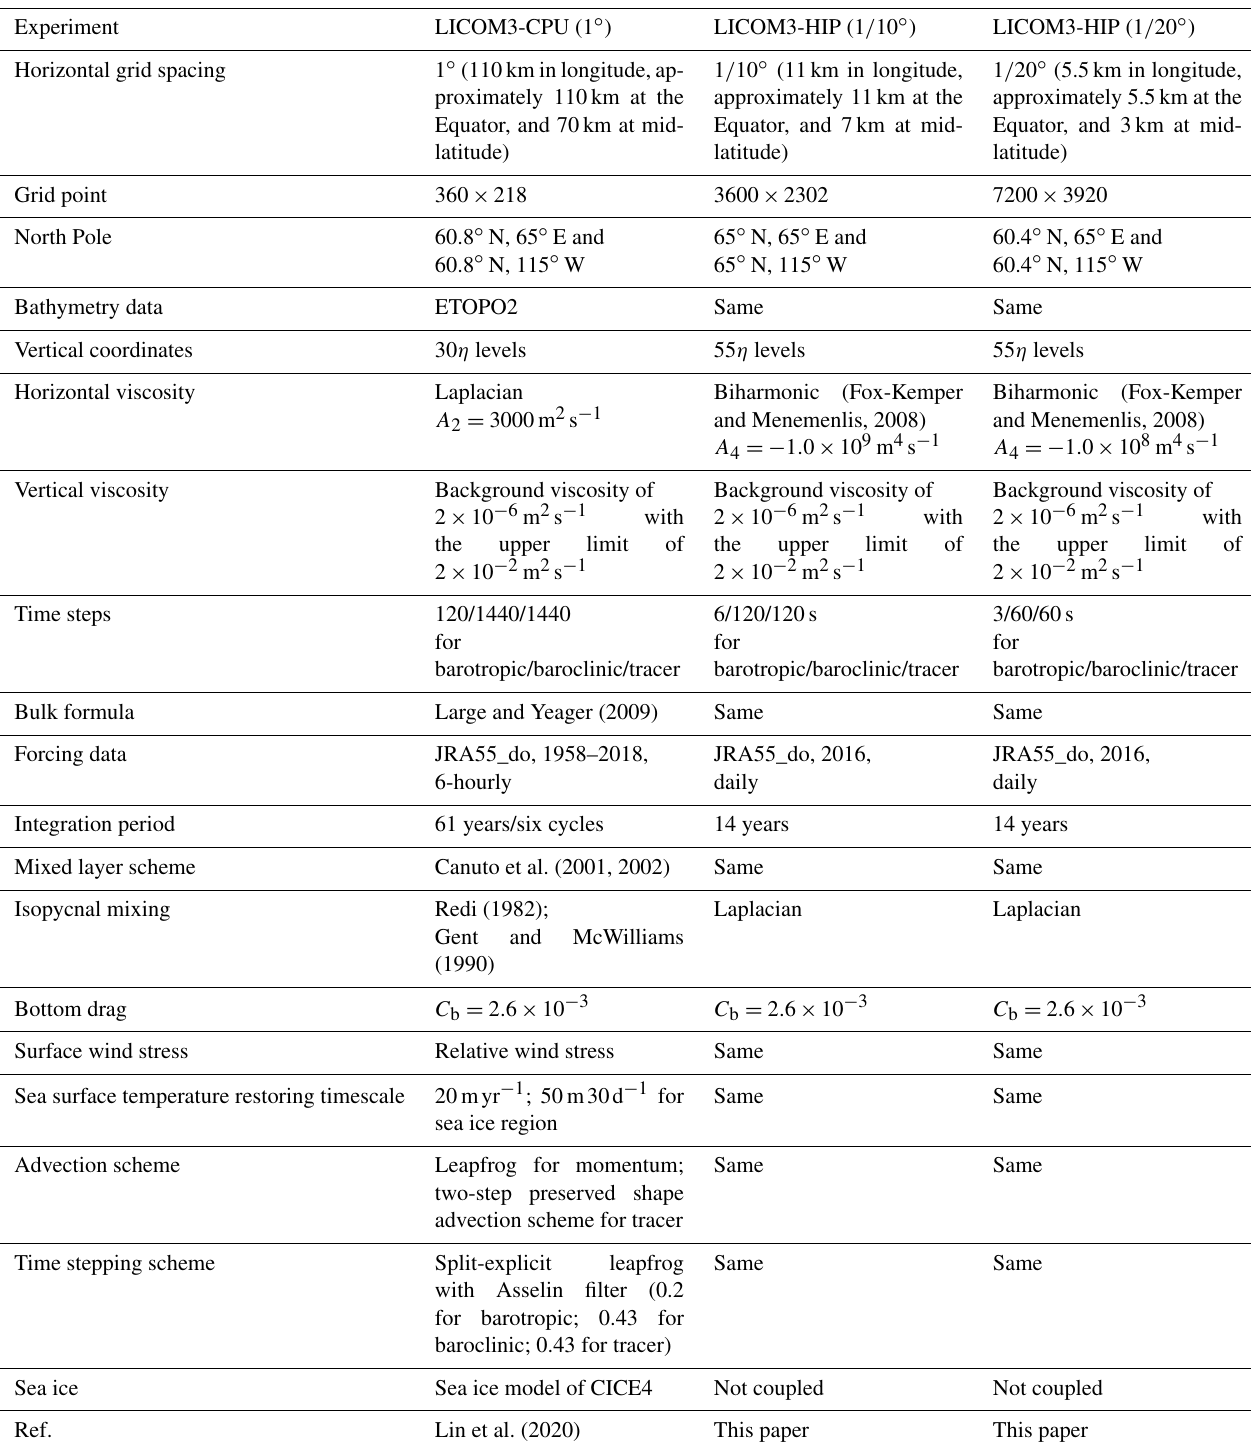
Table 1. Configurations of the LICOM3 model used in the present